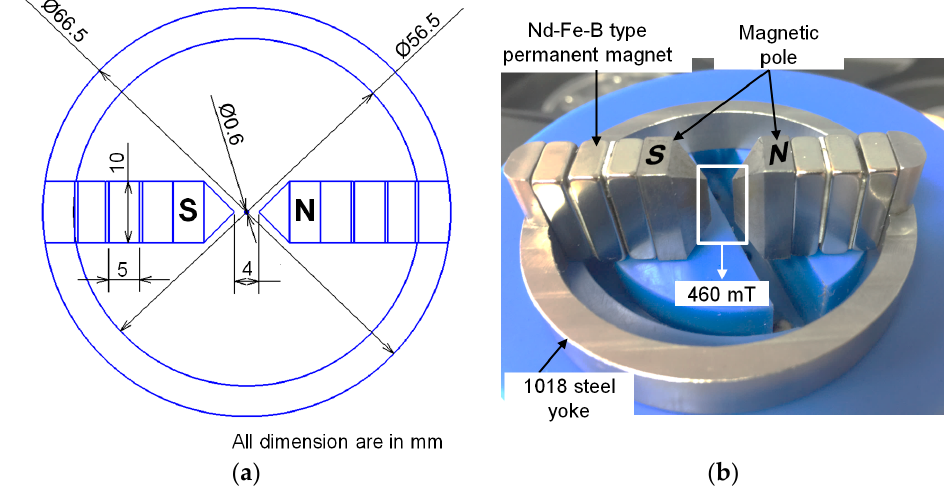
Figure 3. Design of rotating magnetic field used in an ultra-high-precision magnetic abrasive finishing. ( a ) 2D detailed sketch with dimension of rotating magnetic field ( b ) Photograph of rotating magnetic field without an unbonded magnetic abrasive type.